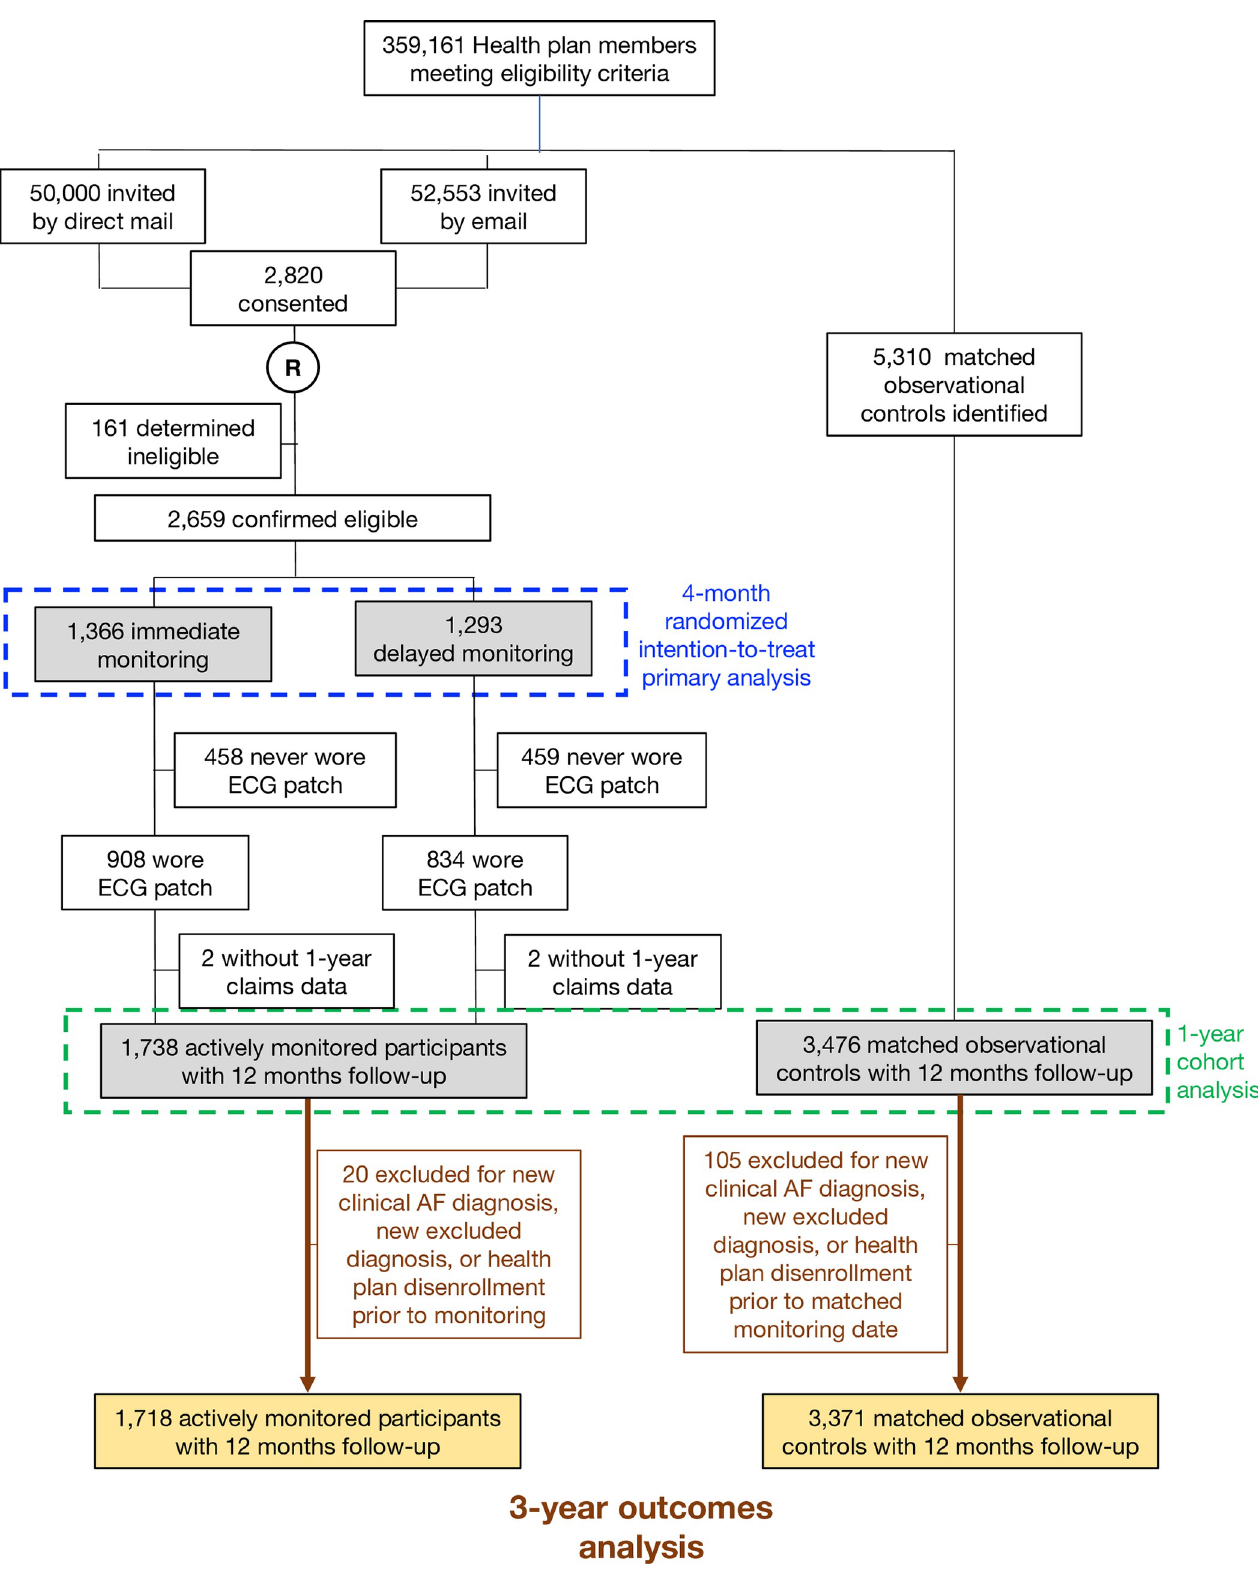
Fig 1. CONSORT flow diagram. Flow of participants beginning with all potentially eligible individuals, those enrolled and then those included in the 4 month, 1-year and 3-year analyses. https://doi.org/10.1371/journal.pone.0258276.g001 PLOS ONE | https://doi.org/10.1371/journal.pone.0258276 October 5,